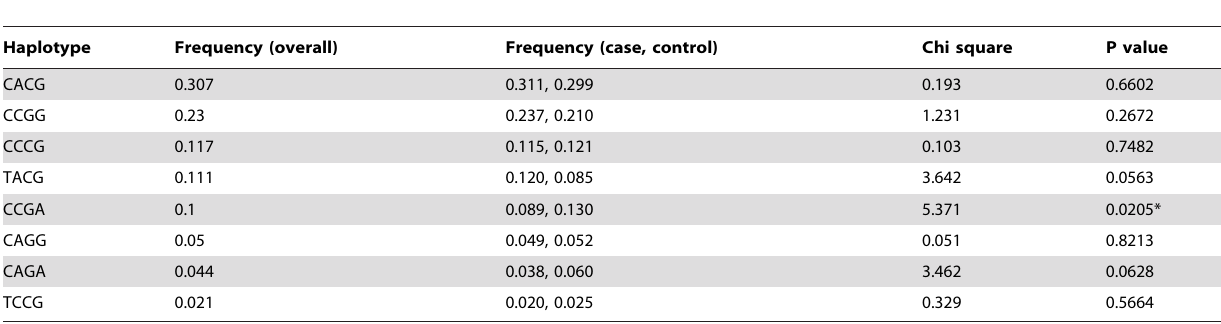
Figure 1. Linkage disequilibrium plot. The number in each cell represents the LD parameter D 9 ( 6 100). Each cell is color graduated related to the strength of LD between the two markers. The rs numbers are SNP IDs taken from the Ensembl database. rs1801133, CM056008 NOIATAUM_DMCH, CM056008 NOIATAUM_DMCH, and rs3818762 are in strong LD. doi:10.1371/journal.pone.0069180.g001 between cases and controls using Vassar Stats Online Calculator (http://faculty.vassar.edu/lowry/VassarStats.html), adopting (count , 20million/ml, . =20 million/ml and , 100 million/ml, Table 5. Common MTHFR haplotypes in relation to male